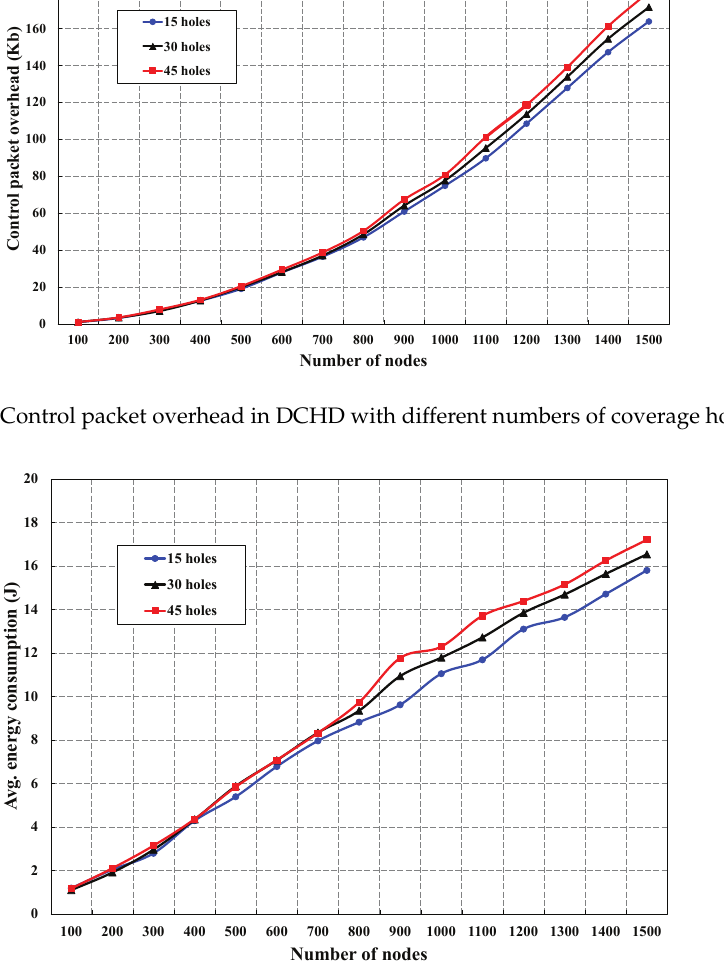
Figure 10. Energy consumption in DCHD to detect different numbers of coverage